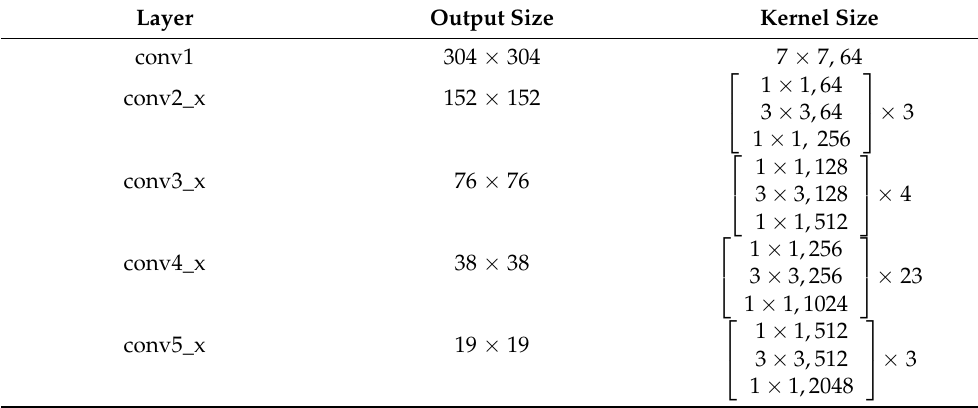
Table 1. Applied kernels of ResNet101 in DamperYOLO.